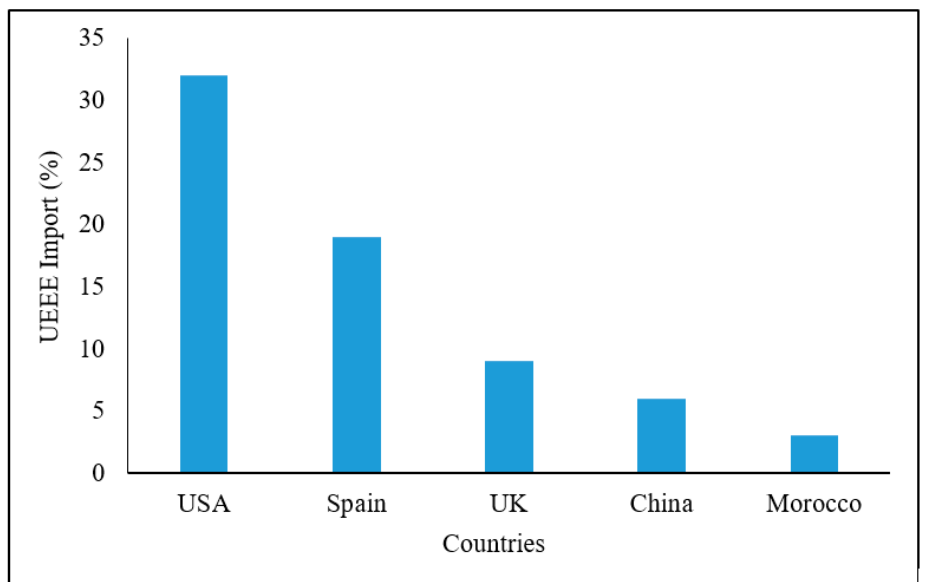
Figure 3. Origins of UEEE imported into the Tin Can Island Port Complex and the Lagos Port Complex, Nigeria in 2015 and 2016 in containers with vehicles. Adapted from Odeyingbo et al. [149].